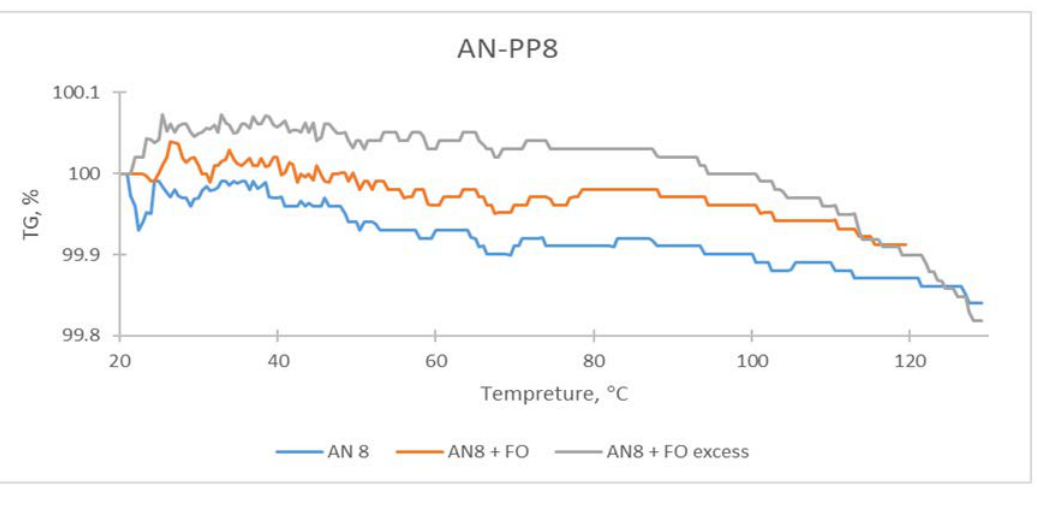
Figure 4. TG results of AN-PP8.